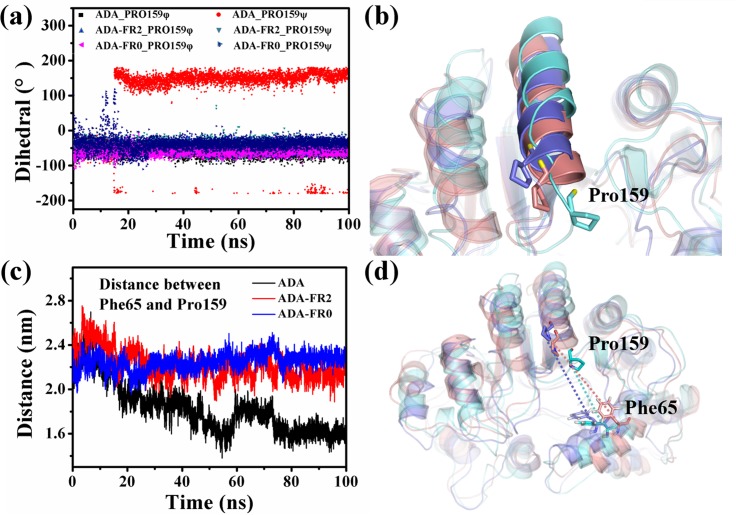
(a) Dihedral changes of Pro159 of the three systems. (b) Residues P159 to K171 are shown in cartoon, and Pro159 is shown in sticks. ADA is in cyan; ADA-FR2 is in salmon; and ADA-FR0 is in slate. (c) Distance changes between Phe65 and Pro159 of the three systems in the 100 ns simulations. (d) Distance between Phe65 and Pro159 of the three systems (ADA in cyan, ADA-FR2 in salmon, and ADA-FR0 in slate).